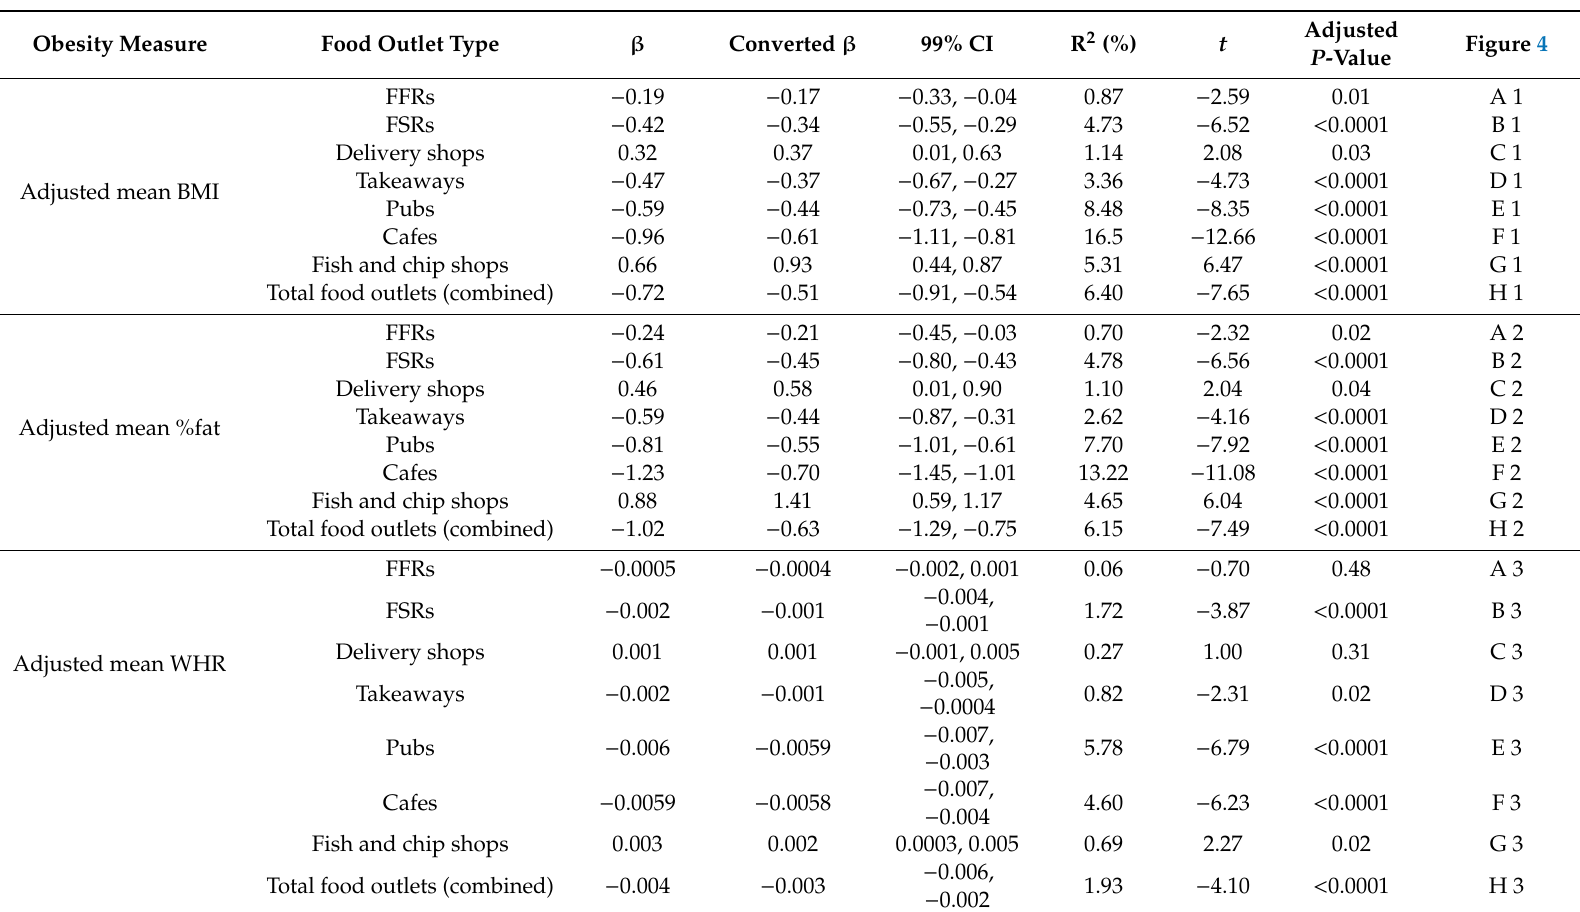
Table 7. Females: Linear regression analysis of the association between log-transformed numbers of food outlets per 1000 population and adjusted obesity measures. Obesity